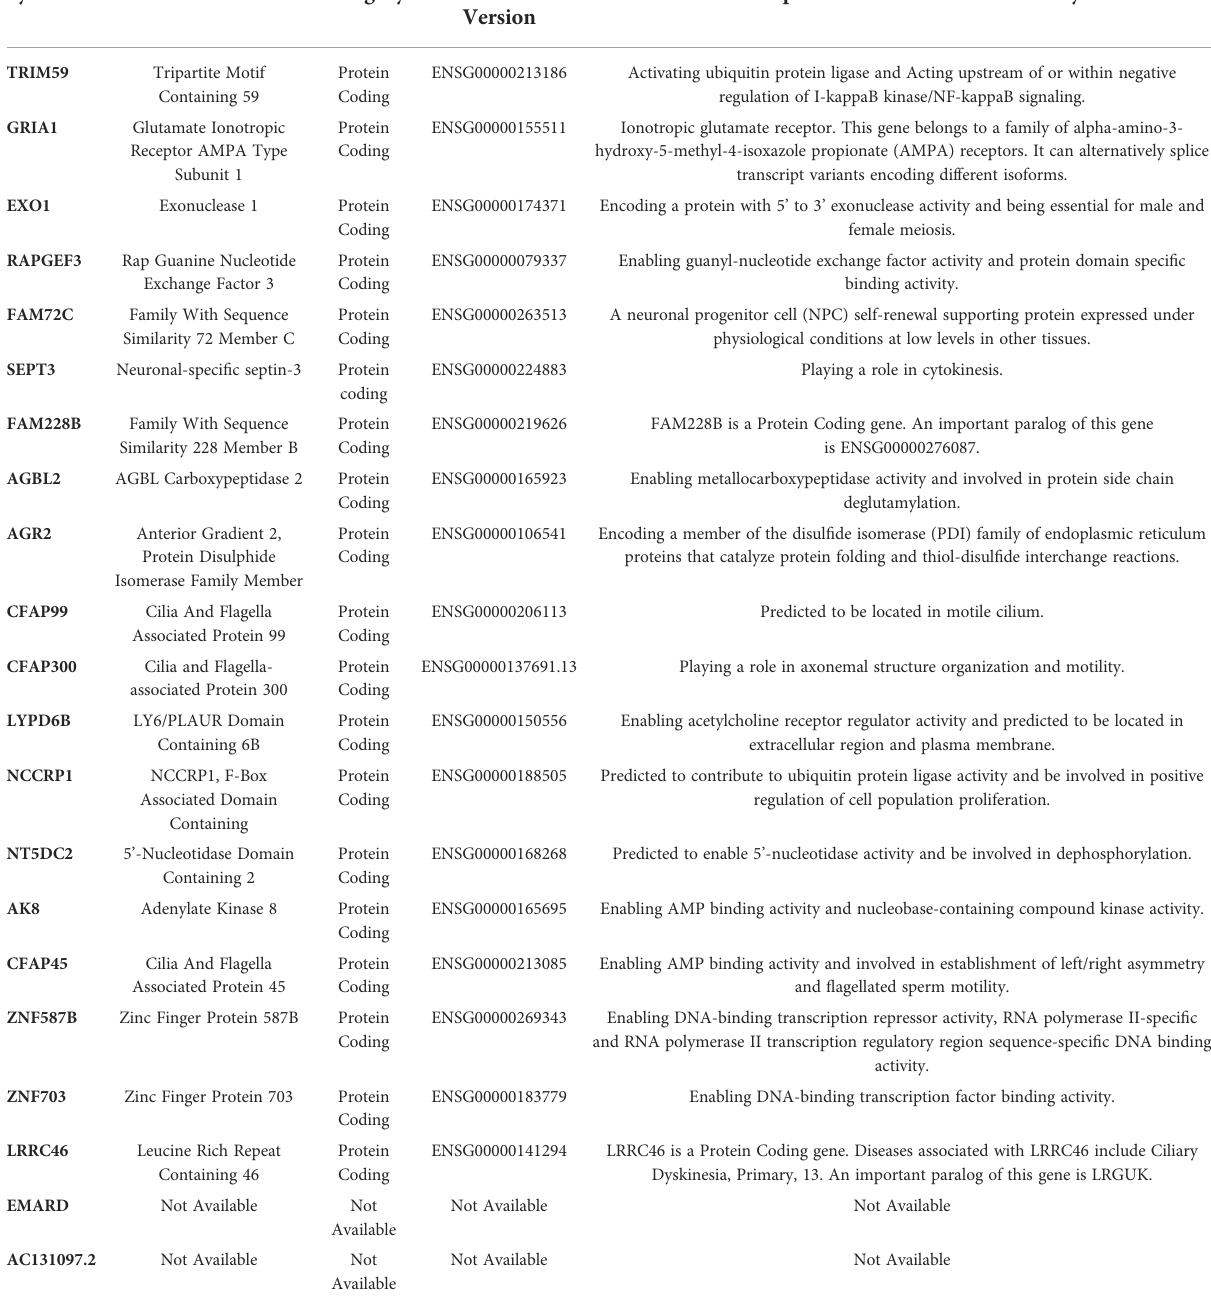
TABLE 3 The 21 prognostic genes for constructing the risk predictive